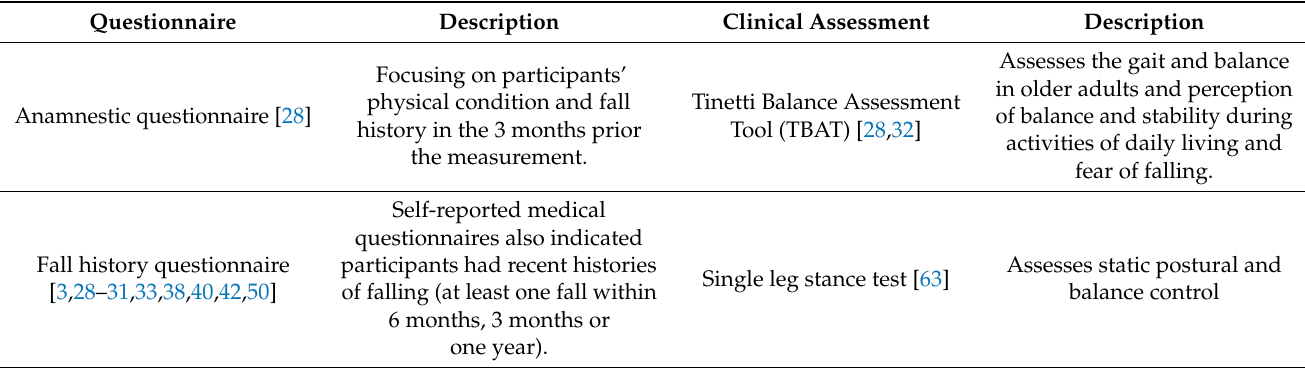
Table 2. Fall risk assessment tools used across